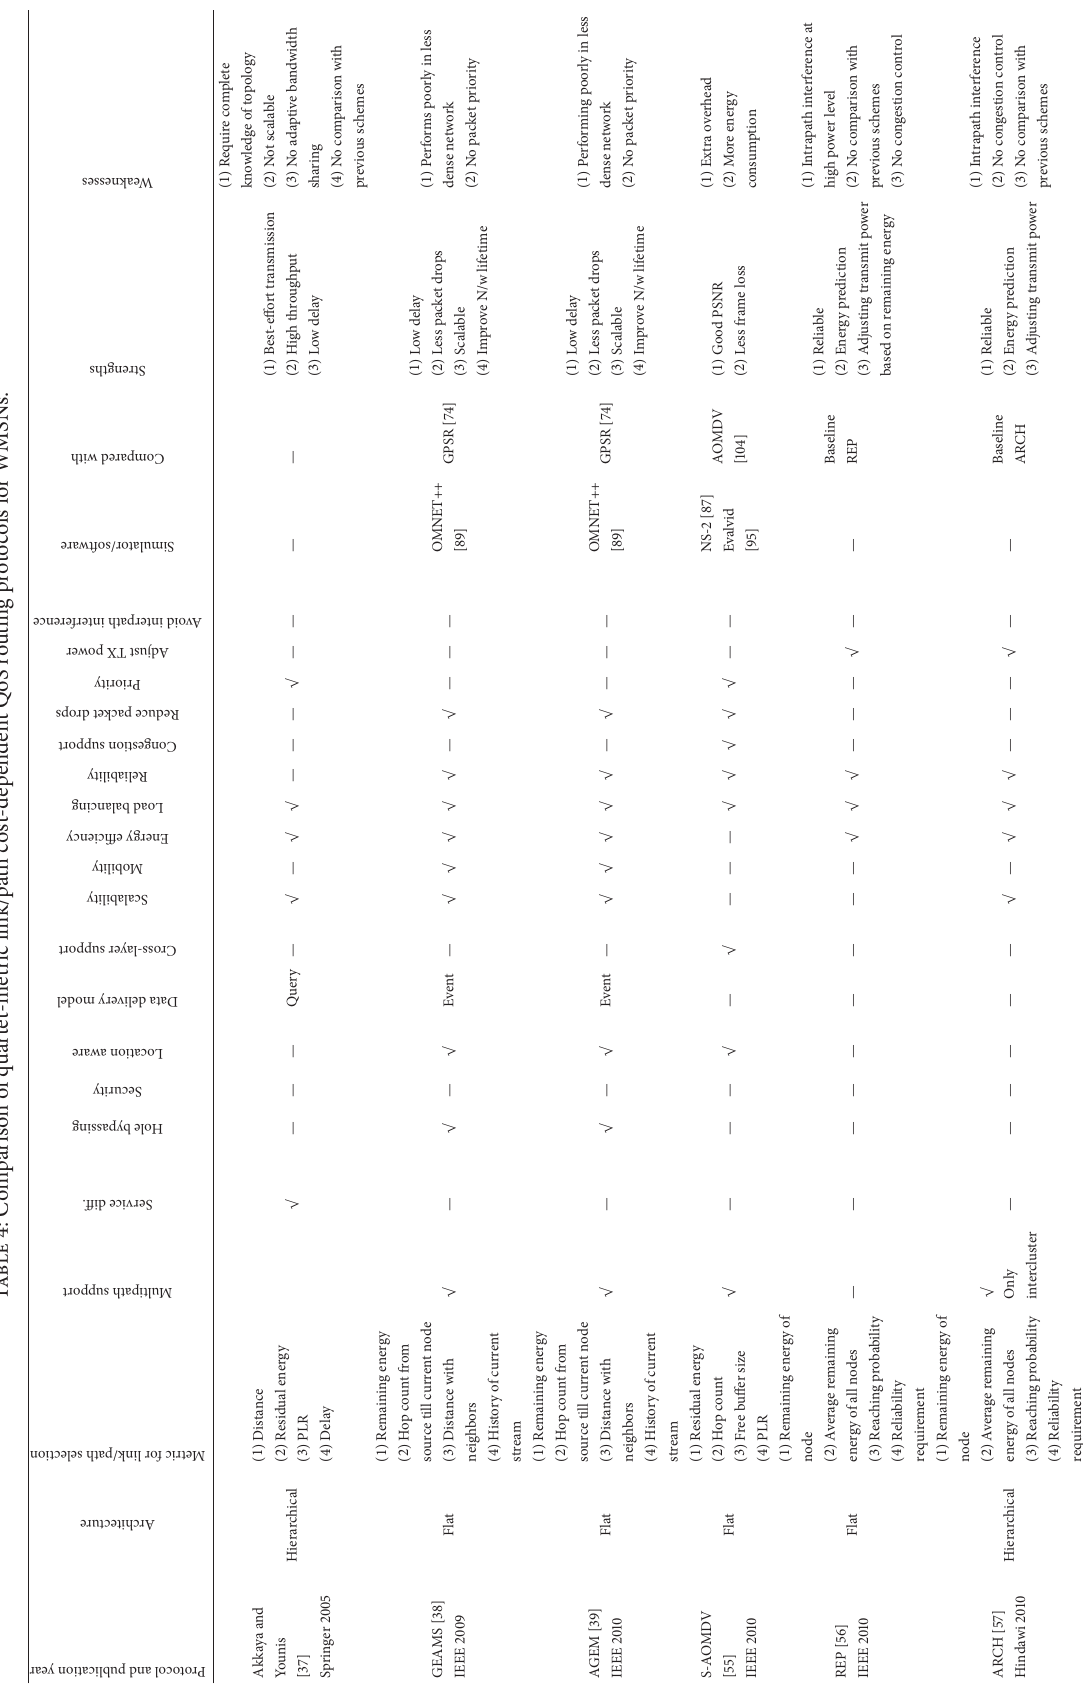
Protocolandpublicationyear